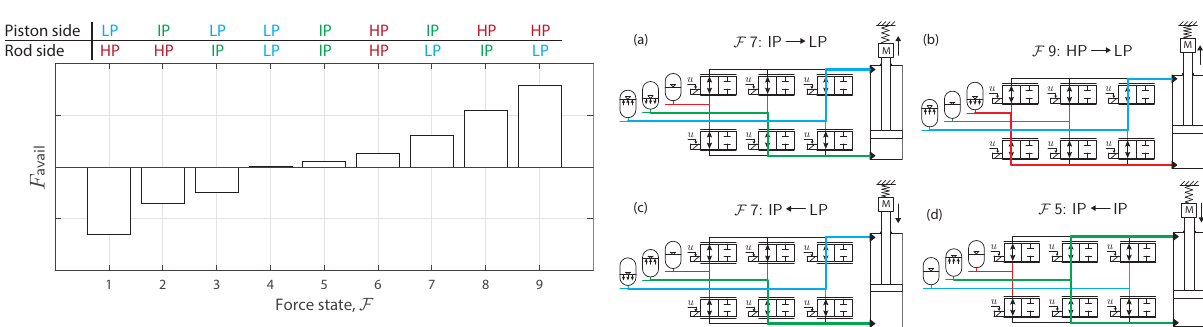
Figure 2: Available cylinder forces depending on the pressure line combinations.